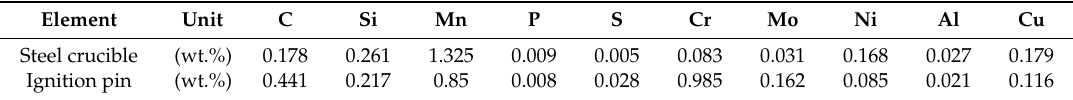
Table 7. Chemical composition of the ignition pin and steel crucible